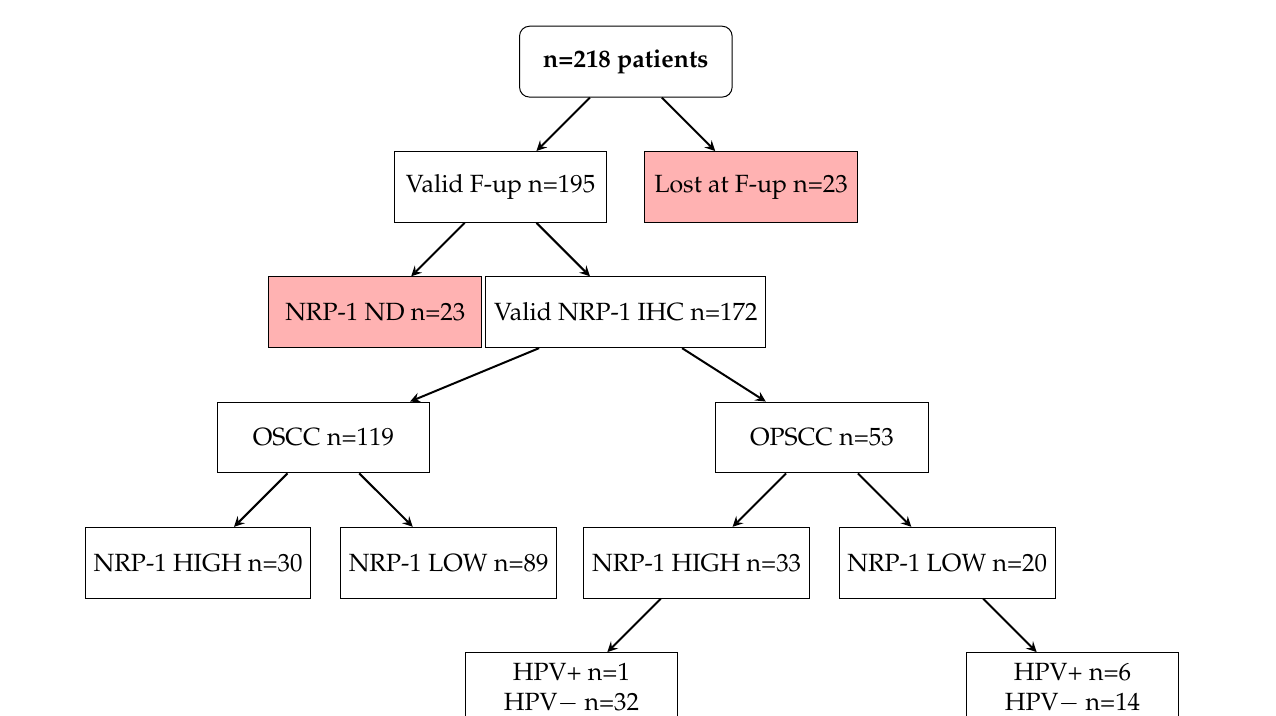
Figure 1. Study population composition and distribution of samples according to the tumor site and NRP-1 positivity groups. OPSCC samples were further classified according to HPV positivity. Nrp: Neuropilin-1; ND: not detectable; OSCC: Oral Squamous Cell Carcinoma; OPSCC: Oropharyngela Squamopus Cell